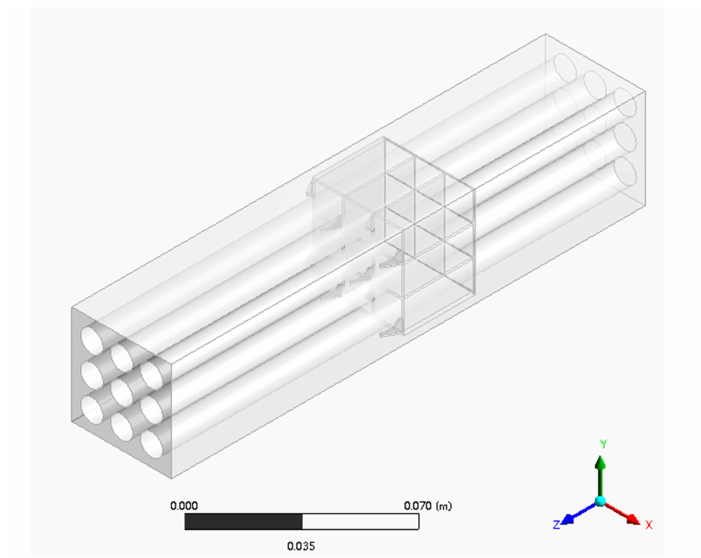
Figure 6. Fluid computing